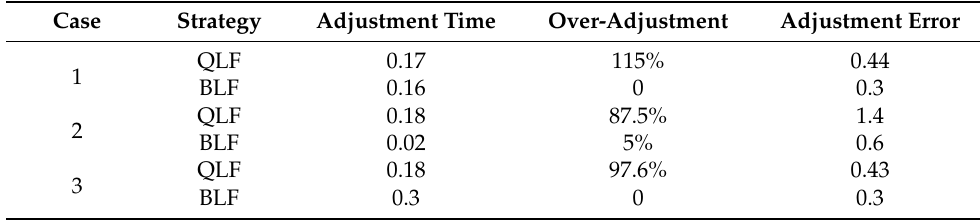
Table 3. The Performance